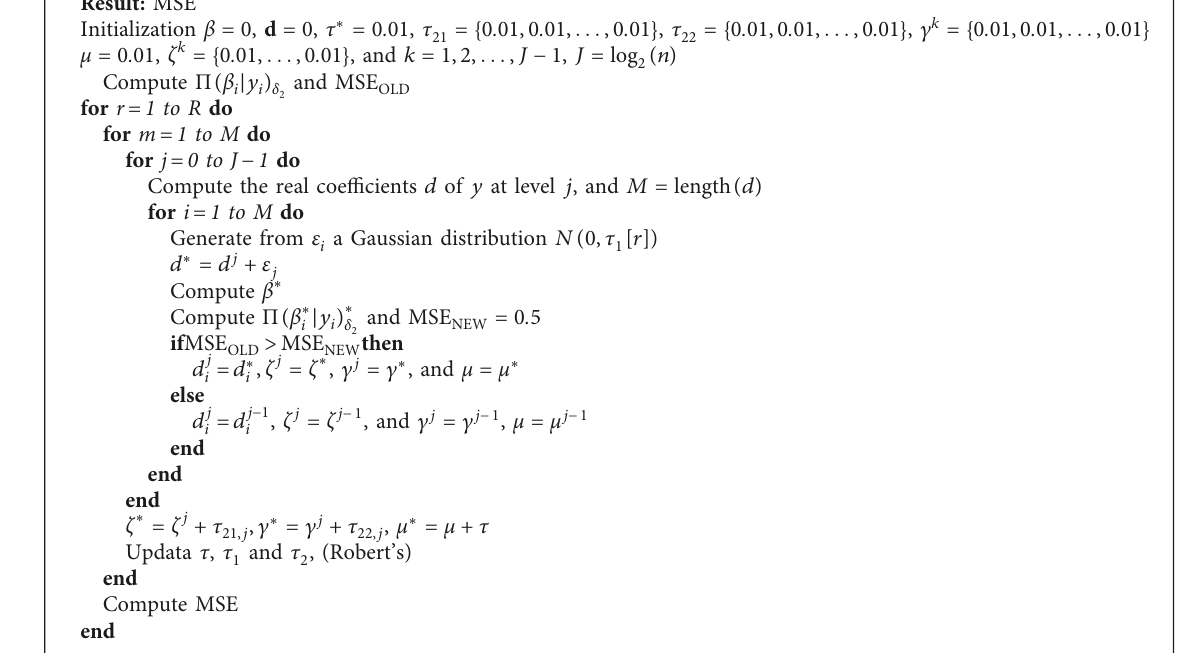
A LGORITHM 2: MSE algorithm for level-dependent prior